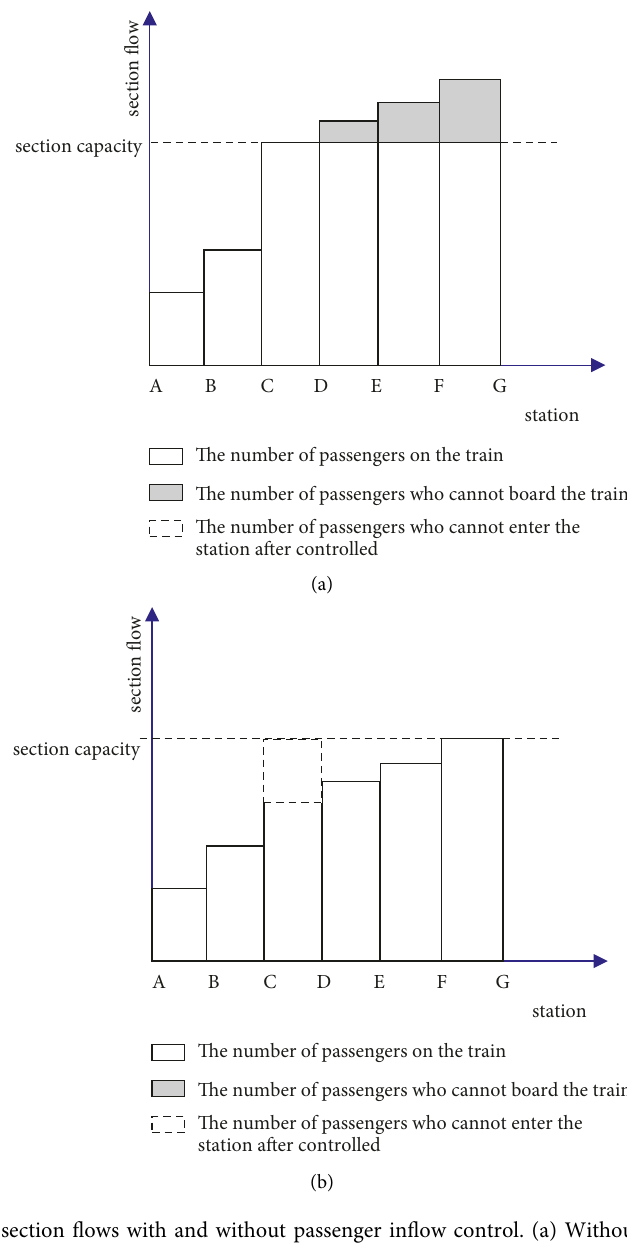
Figure 3: Comparison of section flows with and without passenger inflow control. (a) Without control. (b) With